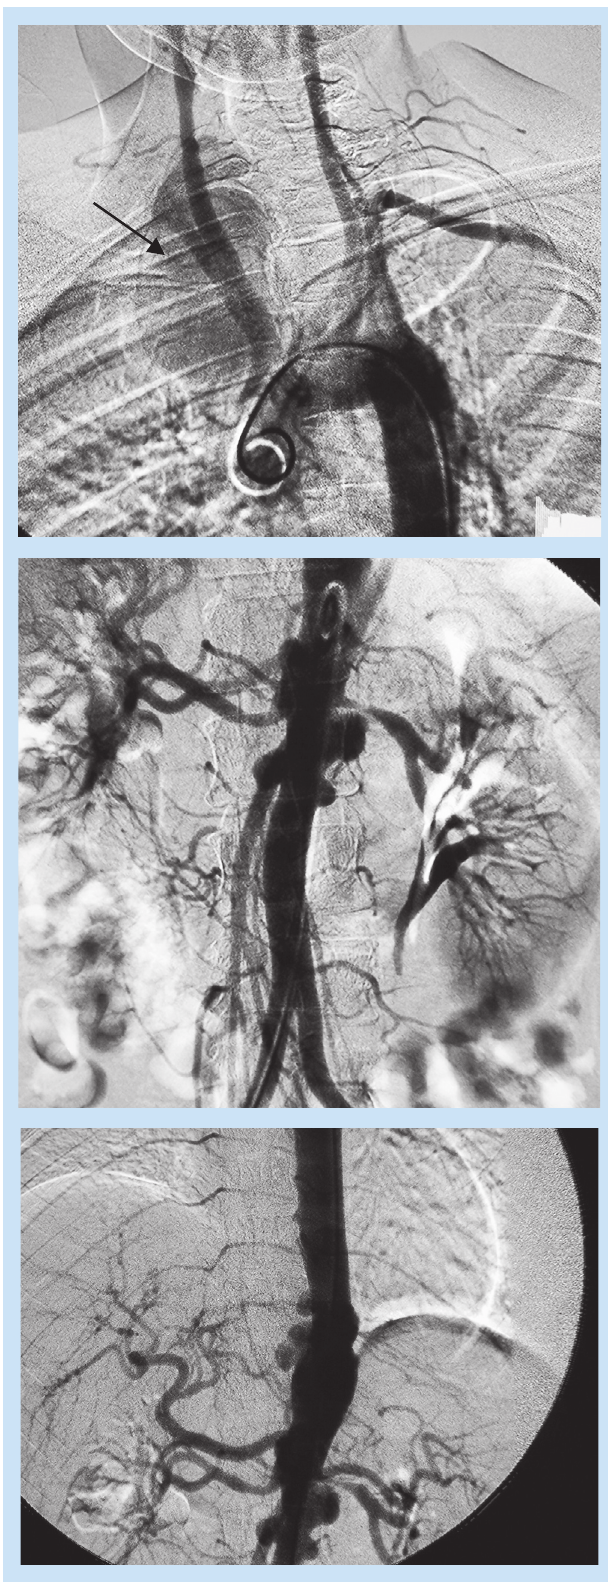
Fig. 10. Aortic angiogram confirmed the CT findings. The thoracic and abdominal aorta showed multiple false aneurysms of medium and small size. The patient underwent surgery to repair the symptomatic superior mediastinal aneurysm (arrow) and recovered well